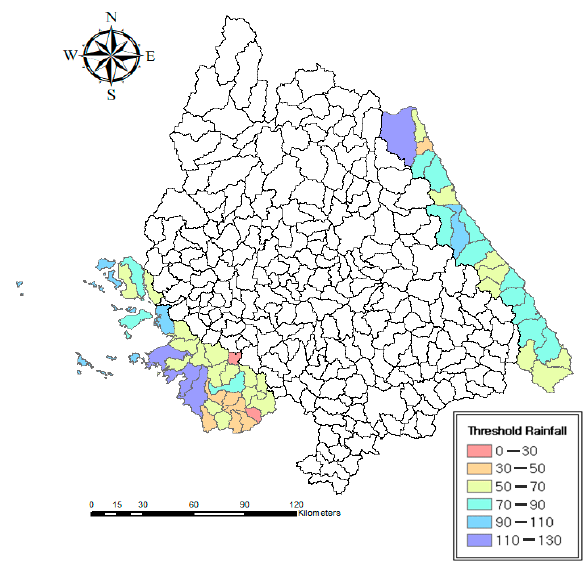
Figure 13. Threshold rainfall values for ungauged watersheds.